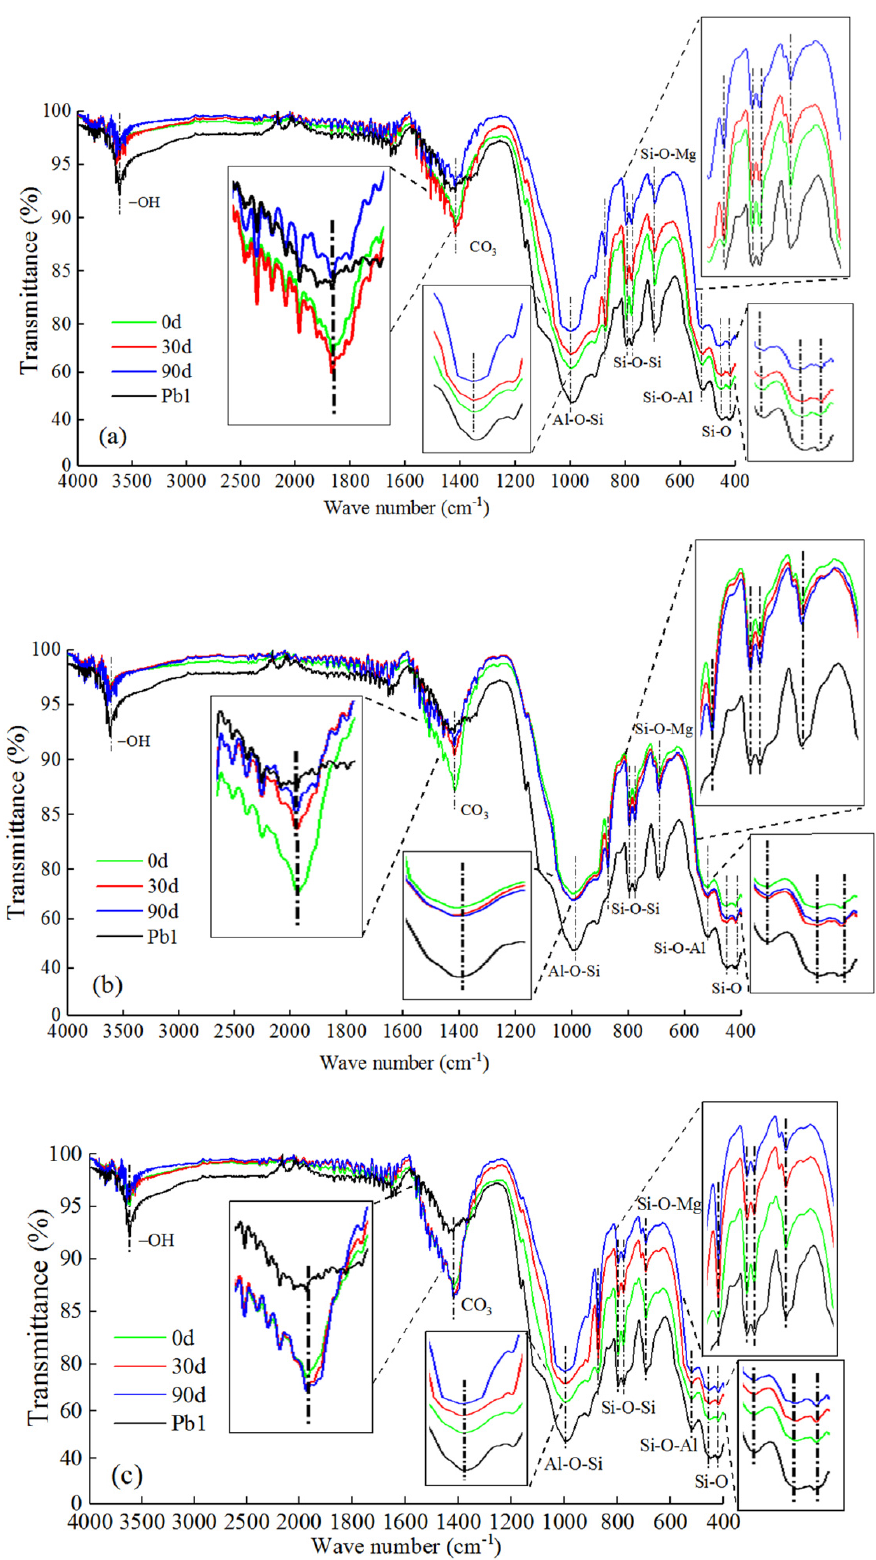
Figure 18. FTIR spectra of Pb-contaminated soil and Pb-CSCSs under freeze-thaw cycles: ( a ) C2.5S5F5Pb1; ( b ) C5S2.5F2.5Pb1, and ( c ) C5S5Pb1.